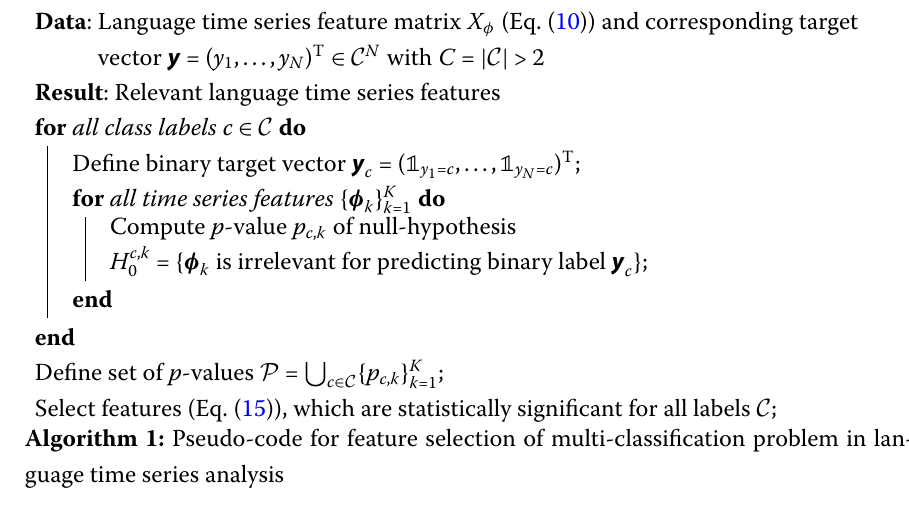
Algorithm 1: Pseudo-code for feature selection of multi-classification problem in lan- guage time series